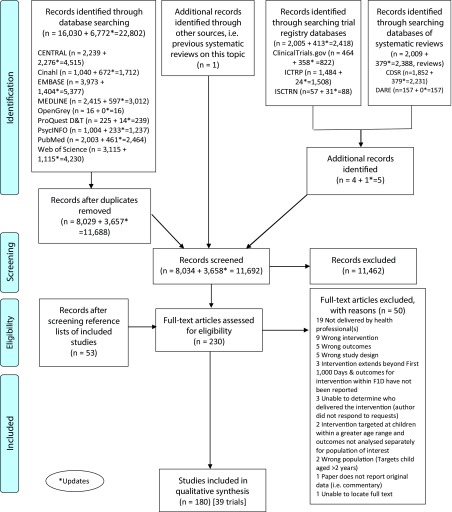
PRISMA flow diagram.